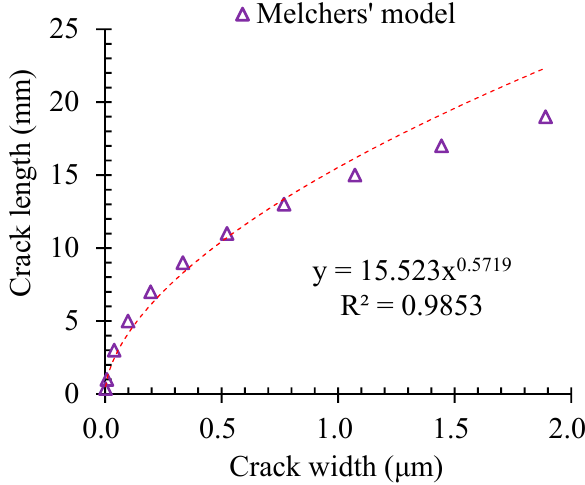
Figure 13. Relationship of the length and width of the corrosion-induced cracking path.